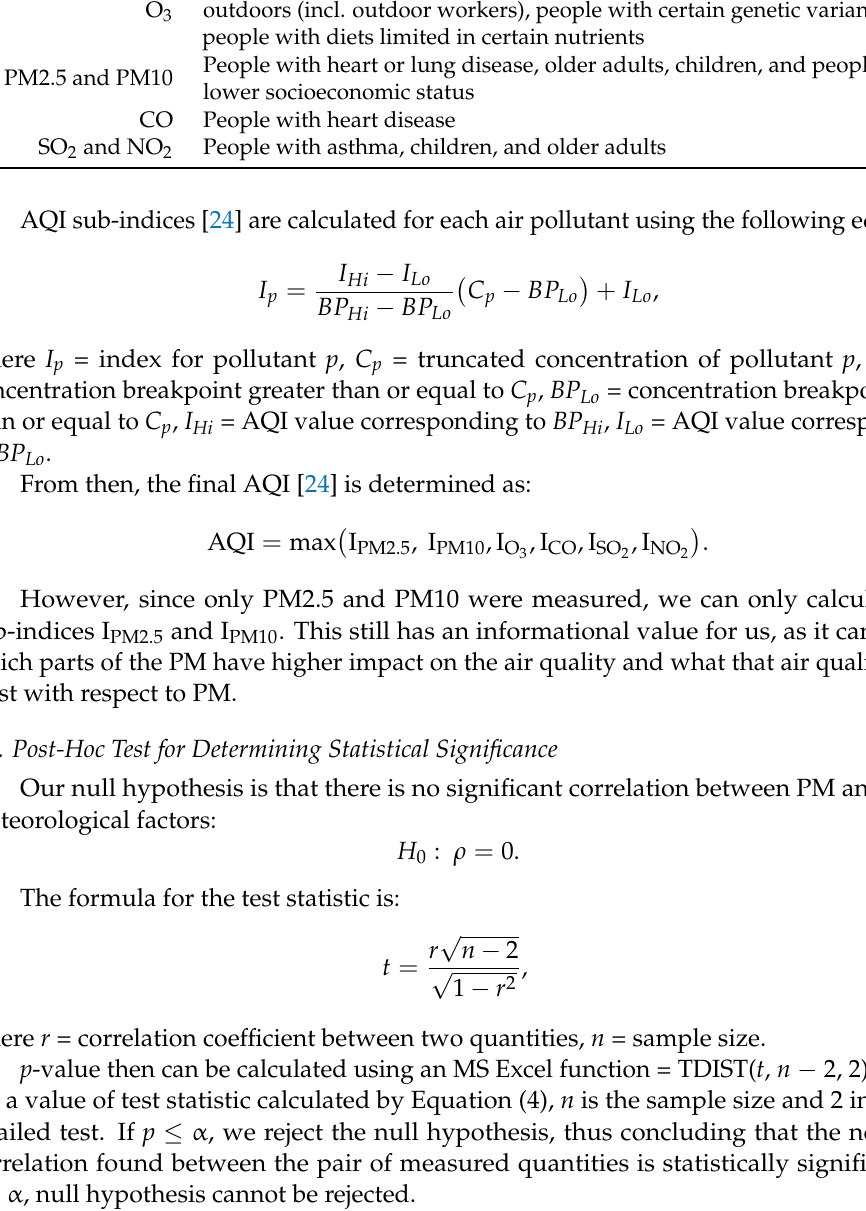
Table 2. AQI categories and their corresponding levels of air pollutants. Adapted from [24]. Air Pollutant Sensitive Groups People with lung disease, children, older adults, people who are active O 3 outdoors (incl. outdoor workers), people with certain genetic variants, and people with diets limited in certain nutrients People with heart or lung disease, older adults, children, and people of PM2.5 and PM10 lower socioeconomic status CO People with heart disease SO 2 and NO 2 People with asthma, children, and older